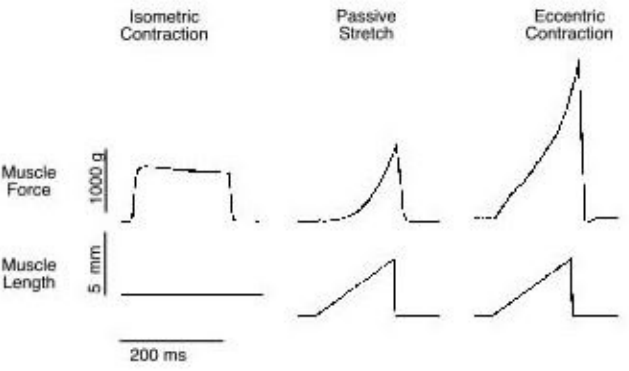
Figure 3. Different types of muscle contractions based on muscle force and